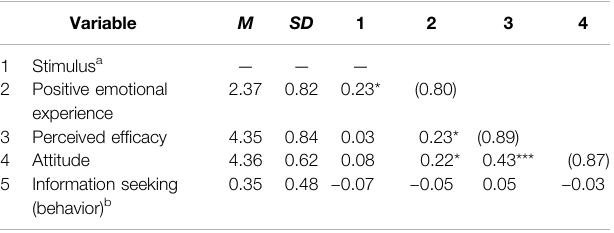
TABLE 1 | Study 1: means, standard deviations, Pearson zero-order correlations, and internal consistencies/correlations.